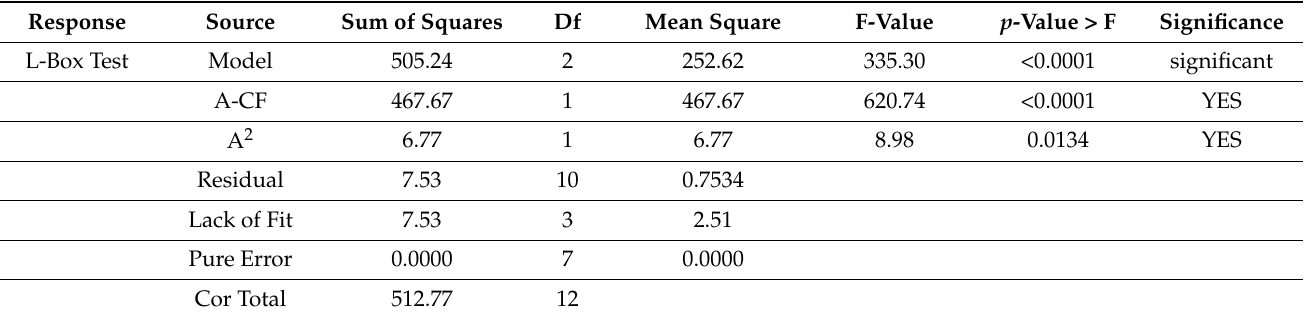
Table 5. ANOVA Results for the Variable Response L-Box test.